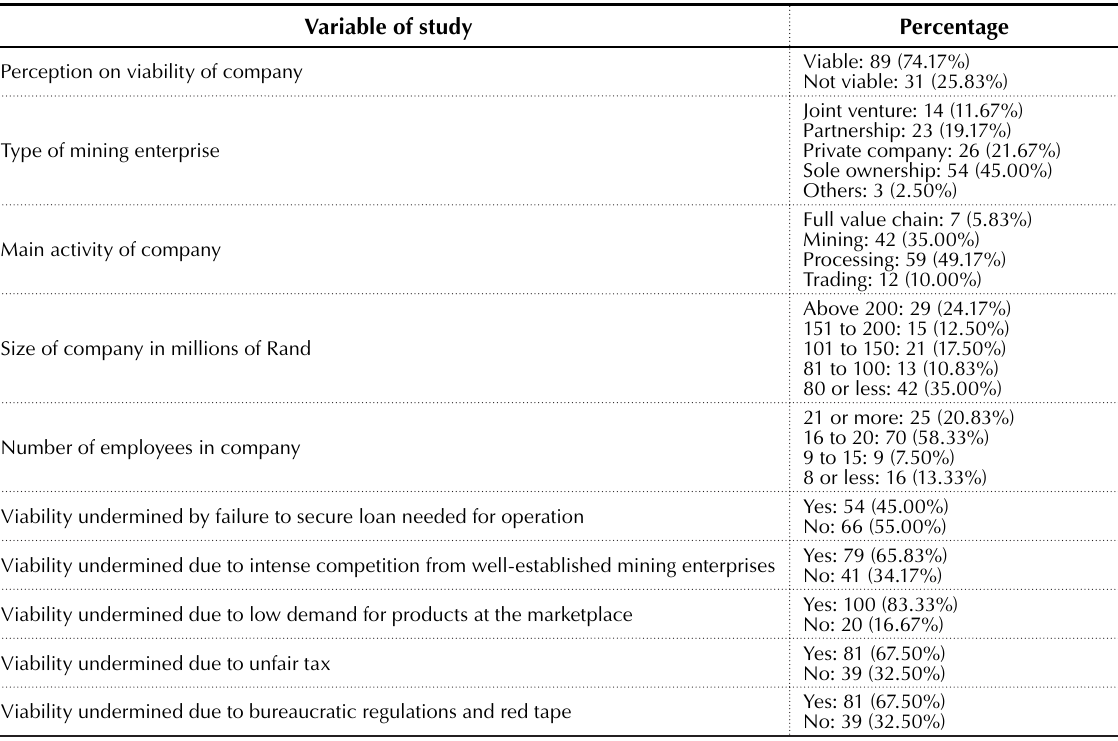
Table 1. General characteristics of respondents (n = 120)